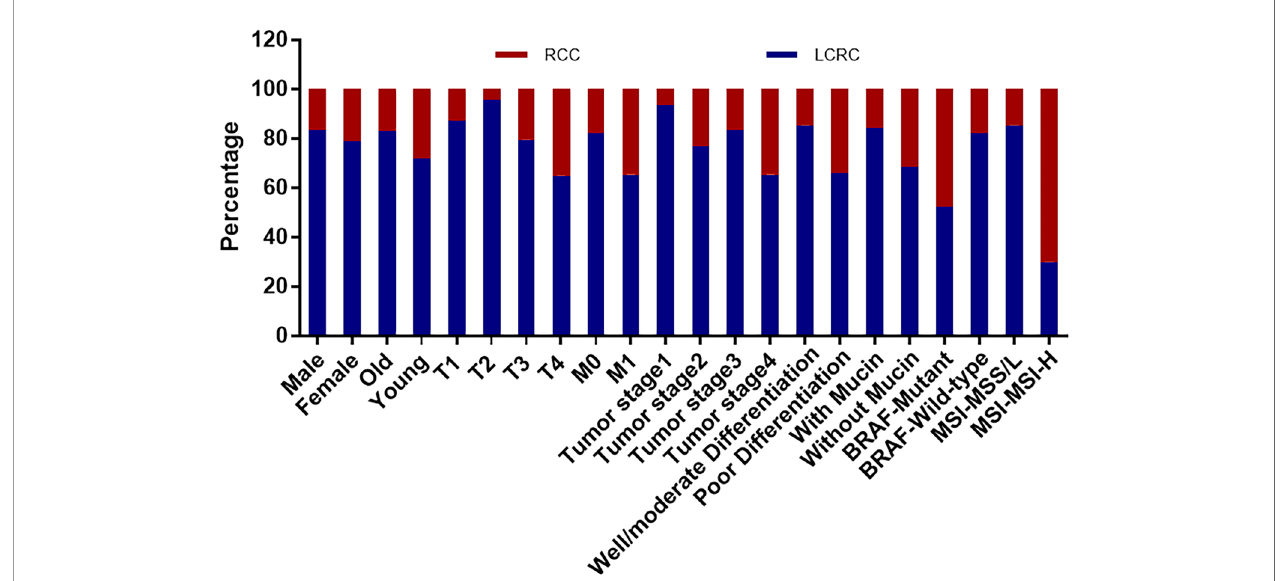
FIGURE 2 | The correlation between clinicopathological characteristics and tumor locations that shows statistically signi fi cant difference. Compared with LCRC, RCC is more relevant with higher frequencies of MSI-high (MSI-H) and BRAF mutation, and higher incidence in female and younger patients, and was closely associated with bowel wall invasion, metastasis, poor differentiation, and mucinous tumors. (LCRC, left-sided colorectal cancer; RCC, right-sided colorectal cancer; MSI, microsatellite instability; MSS/L, microsatellite stable plus microsatellite instability-low; MSI-H, microsatellite instability-high; Old, ≥ 50 years old; Young, <50 years old; T, bowel wall invasion; M,